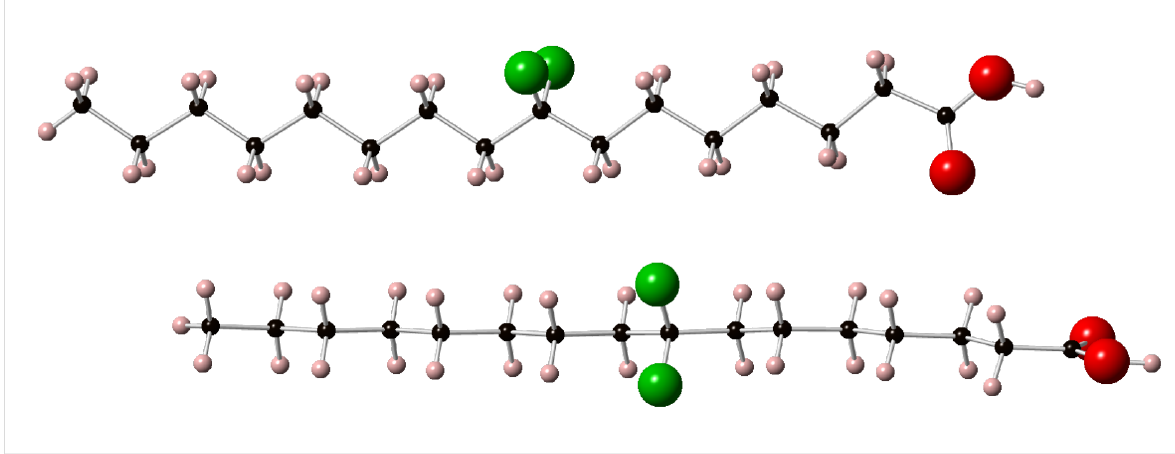
Figure 5: The X-ray crystal structures of 8,8-difluorohexadecanoic acid ( 6a ).